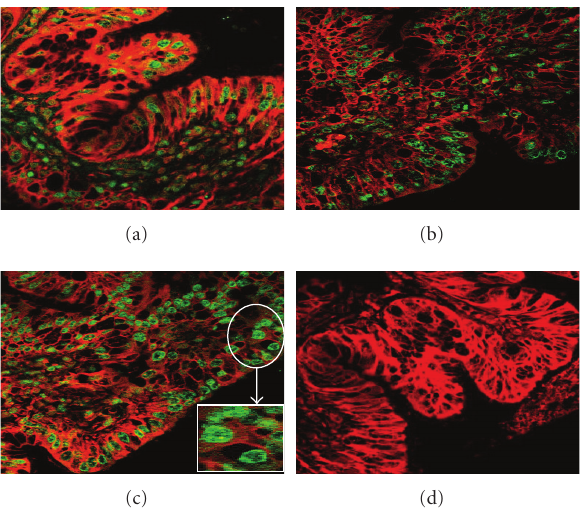
Figure 1: Laser Scanning Confocal Microscope (LCMS) images of TLR-9 protein expression in rabbit CVE after intravaginal administration of nisin (15.15mM in 2mL of 1% polycarbophil gel) (b), SDS (56 μ M in 2mL of 1% polycarbophil gel), (c) and 2mL of 1% placebo gel (a) for 14 consecutive days. Expression was found to be localized in the cytoplasm of cells. Note significant increase of TLR expression in SDS gel group (c) compared to placebo (a) and nisin gel administered (b) groups. Similar expression pattern was observed in TLR-5. The figures shown are the representative pictures from three independent experiments (Mag X 40; inset image X 630).